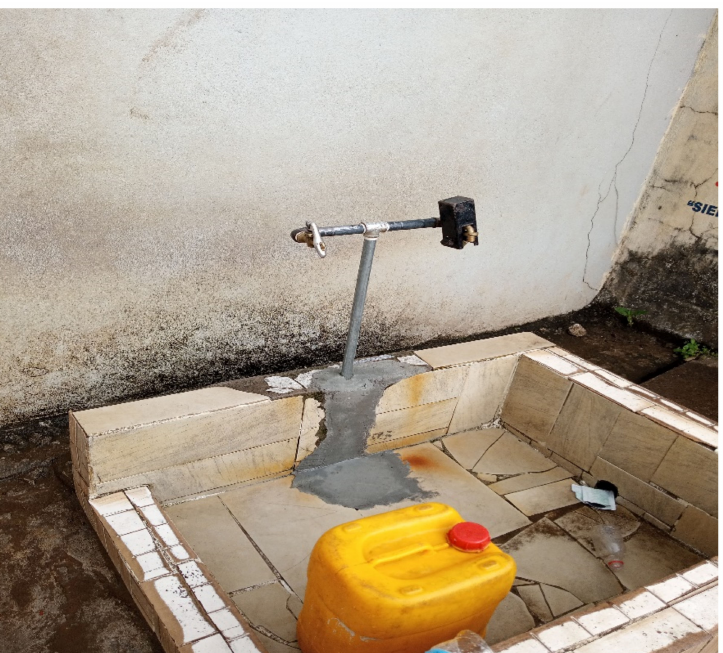
Figure 6. A typical example of one of the standpipes in Brookfields connected to the pipe network. The tap is closed after use by the